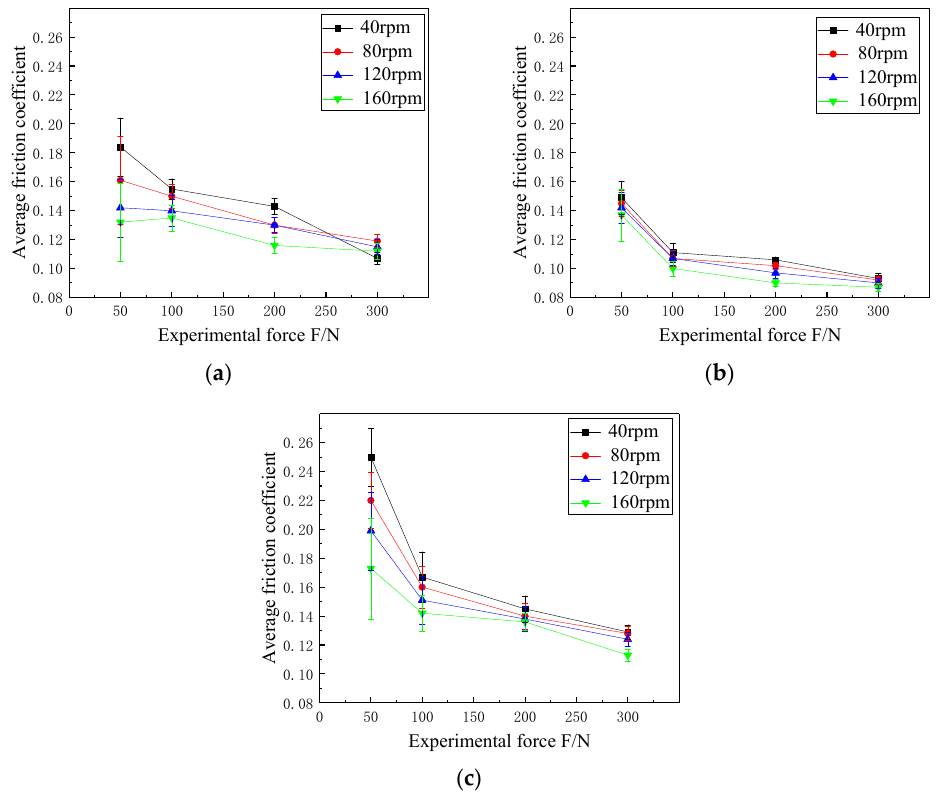
Figure 11. Friction coefficients of semicircular ring textured surface with different area occupancy ratios: ( a ) area occupancy ratio of 7%; ( b ) area occupancy ratio of 10%; ( c ) area occupancy ratio of 13%.